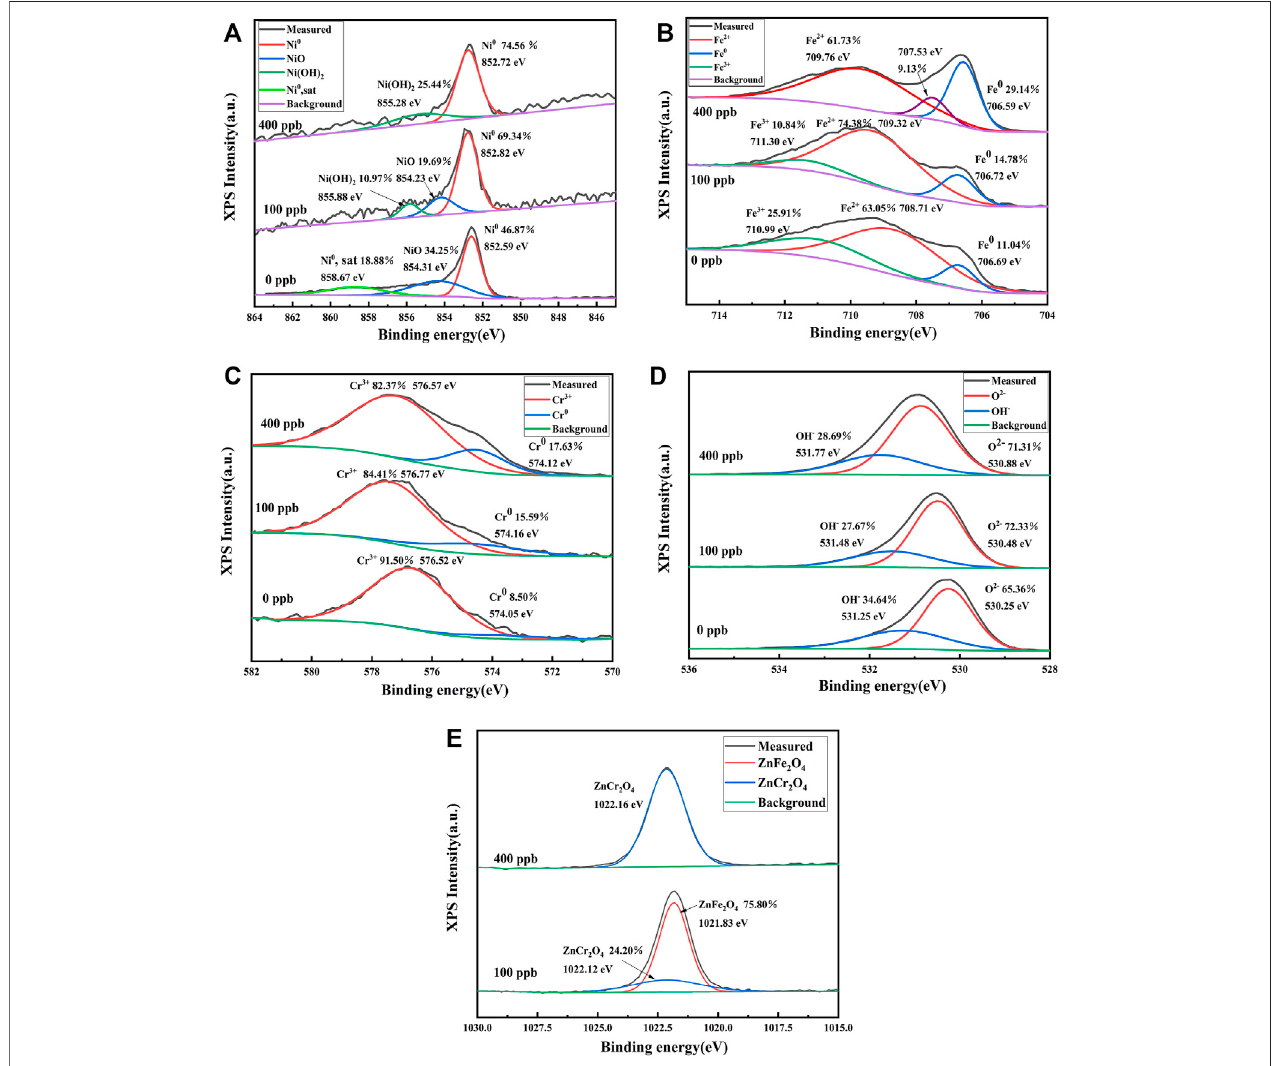
FIGURE 5 | The XPS spectra of oxide fi lms on 304SS exposed to 0, 100 and 400 ppb Zn solutions after sputtering 500 s: (A) Ni 2p3/2 (B) Fe 2p3/2 (C) Cr 2p3/ 2 (D) O 1s (E) Zn 2p3/2.